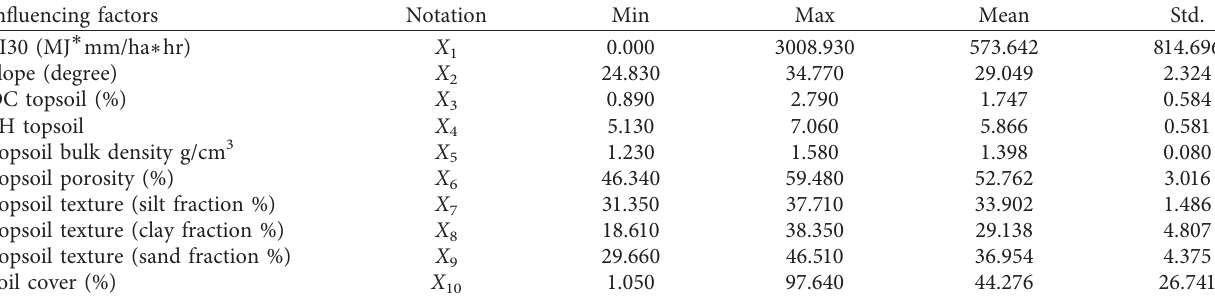
Table 1: Statistical descriptions of soil erosion influencing factors [20].